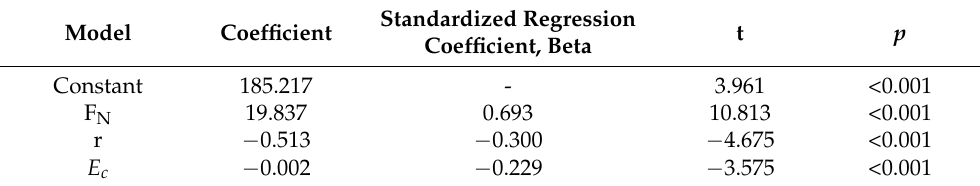
Table 7. Coefficients of the regression model for groove area for single-asperity scratch test.